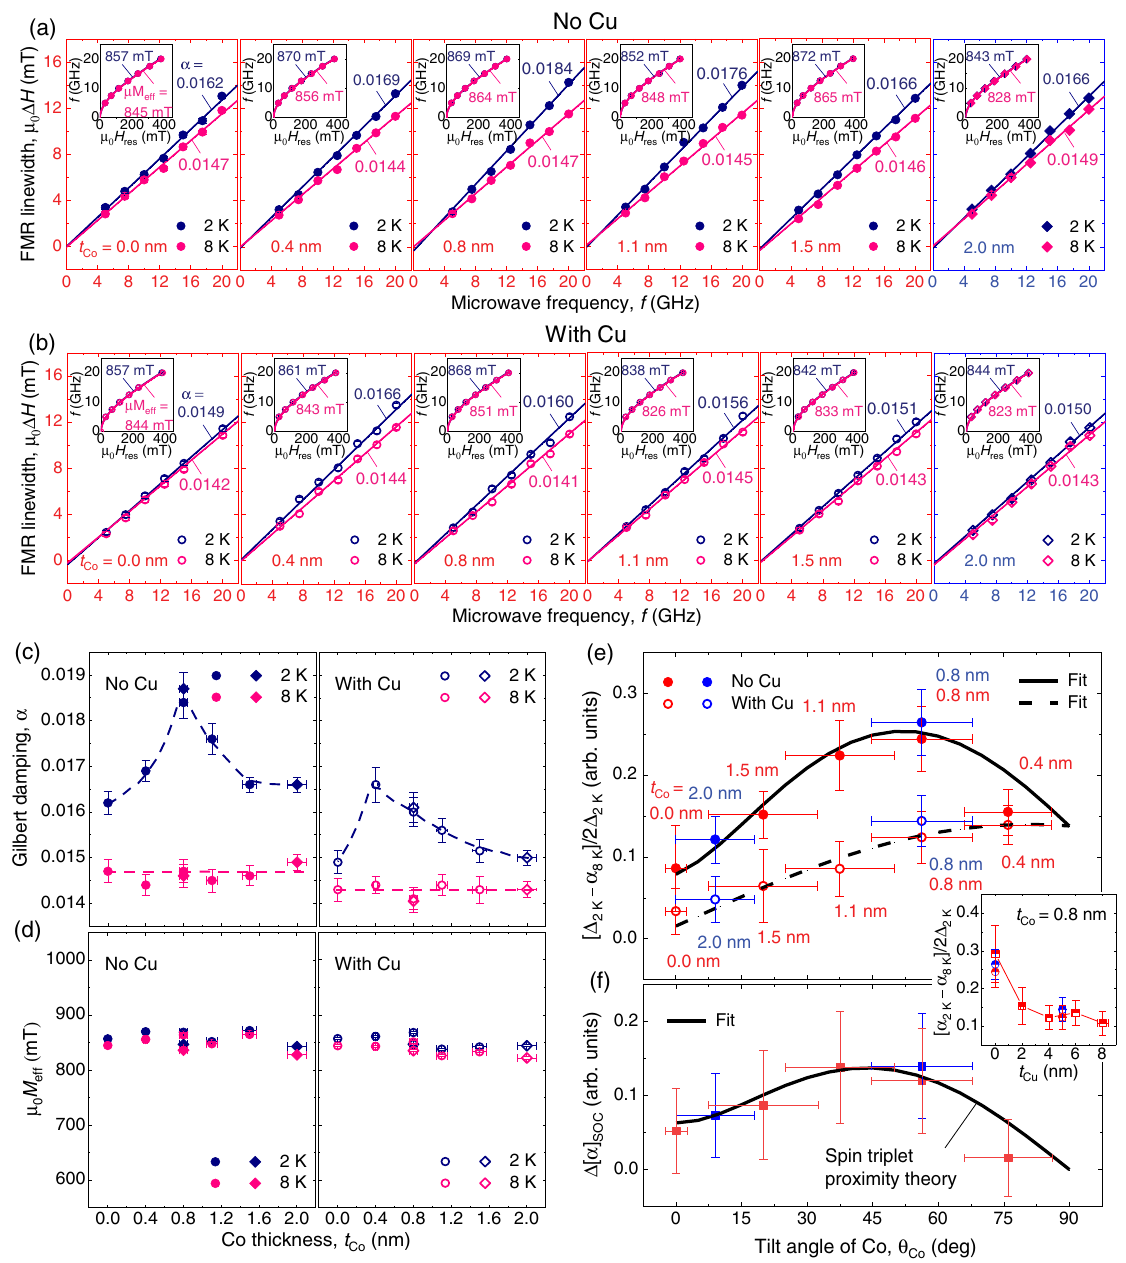
FIG. 2. Correlation of Co tilt angle with superconducting spin-pumping efficiency. (a) Microwave frequency f dependence of = Pt ð 1 . 7 nm Þ = Nb ð 30 nm Þ = Ni 8 Fe 2 ð 6 nm Þ = Nb ð 30 nm Þ = ferromagnetic resonance (FMR) absorption for symmetric Pt ð 2 . 0 nm Þ = Co ð t Co Þ = Pt ð 2 . 0 nm Þ samples with various Co thicknesses, taken above and below T Pt ð 1 . 7 nm Þ = Co ð t of the couple Nb. From this, one can c Co Þ extractthe(effective)Gilbert(-type)damping α andthe(effective)saturationmagnetization μ 0 M .(b)Dataequivalentto(a)butforsymmetric s = Pt ð 1 . 7 nm Þ = Cu ð 5 nm Þ = Nb ð 30 nm Þ = Ni 8 Fe 2 ð 6 nm Þ = Nb ð 30 nm Þ = Cu ð 5 nm Þ = Pt ð 1 . 7 nm Þ = Co ð t = Pt ð 2 . 0 nm Þ samples. Pt ð 2 . 0 nm Þ = Co ð t Co Þ Co Þ Note that in any case, the zero-frequency line broadening μ 0 Δ H 0 due to long-range magnetic inhomogeneities is less than j 0 . 5 mT j and the FMR linewidth μ 0 Δ H scales linearly with f , indicating the high quality of the samples and the absence of two-magnon scattering [32]. Extracted α (c) and μ 0 M (d)valuesasa functionof t for thesamples withand without the Cuspacer. The dashedlines areguide tothe eyes. s Co − α 2 Δ 2 Δ is the superconducting gap at 2 K calculated from the measured (e) Damping difference across T , denoted as ½ α 2 8 K (cid:3) = 2 K , where c K T [Fig. 1(d)], as a function of the (effective) Co tilt angle θ . The black solid (dashed) line is a fit from spin-triplet proximity theory [4 – 6,8] c Co fortheCu-absent(Cu-present)samples(Secs.1and2ofSupplementalMaterial [17]).(f),Interfacial SOCcontribution Δ ½ α (cid:3) ,separatedby SOC − α 2 Δ taking the difference between the ½ α 2 8 K (cid:3) = 2 K data (e) with and without the Cu spacer. The black solid line is a theoretical fit based on K Rashba-type SOC-induced triplet paring [6,8] (Secs. 1 and 2 of Supplemental Material [17]). Here, the amplitude and component of Rashba SO field and the exchange field strength are only adjustable parameters to get to the theoretical fit. The inset of (e) and (f) shows ½ α 2 K − α 8 K (cid:3) = 2 Δ 2 K dataasa functionofCuspacerthickness t Cu for the t Co ¼ 0 . 8 nm samples (SupplementalMaterial, Sec.IV[17]). The red and blue symbols in (c) and (d) represent independent sets of the samples grown each in a single deposition